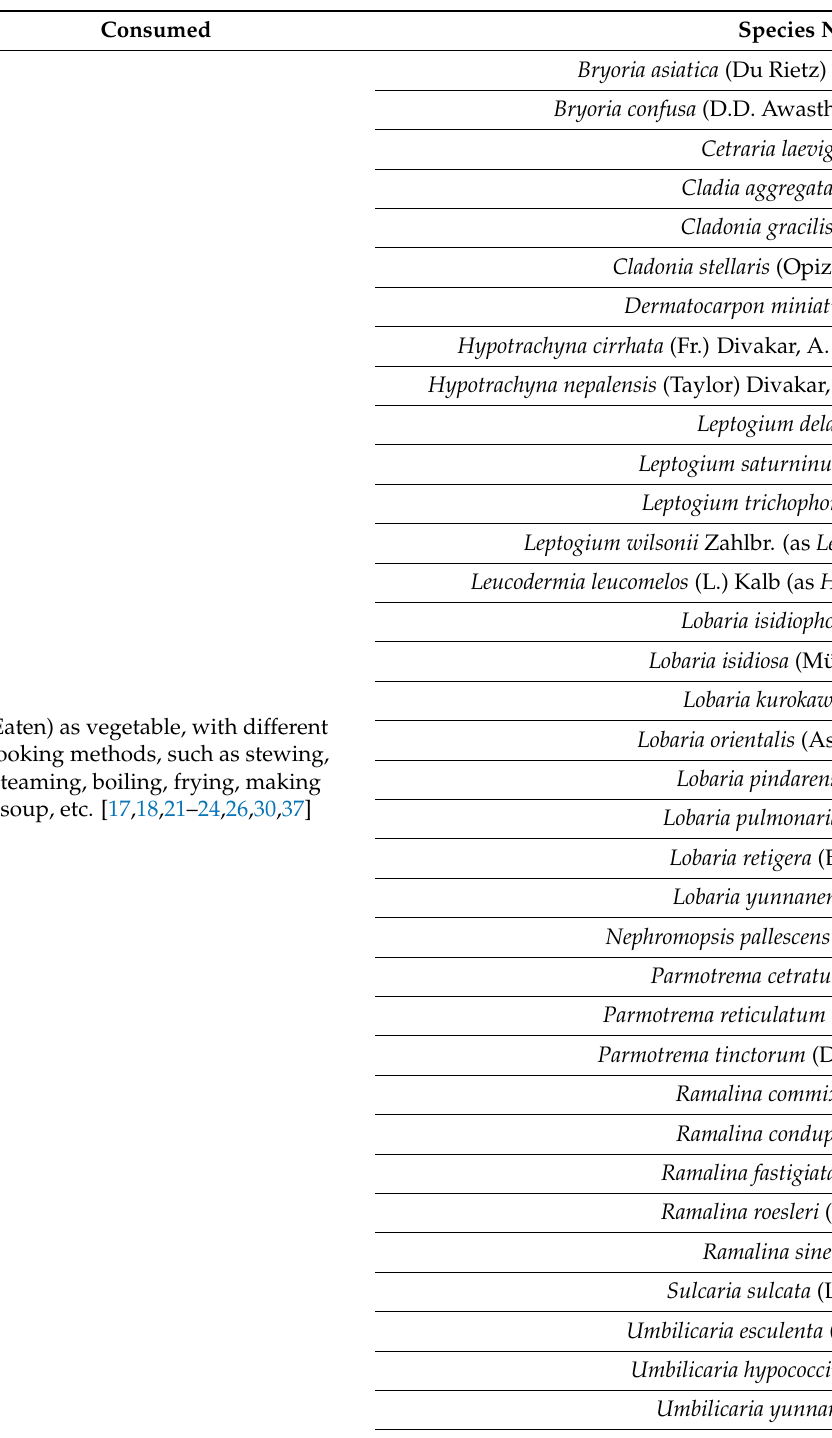
Table 2. Edible lichens in Himalayas and southwestern